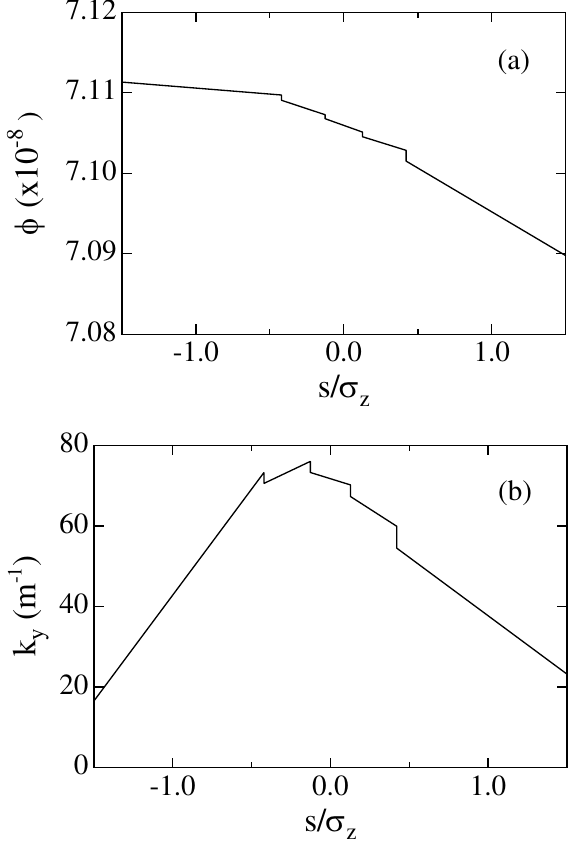
(cid:8) 5 . The sl (cid:6) s (cid:7) and k (cid:8) @ 2 (cid:29) (cid:6) 3 (cid:7) =@y 2 (cid:8) (cid:23) p = (cid:23) y . y y 3